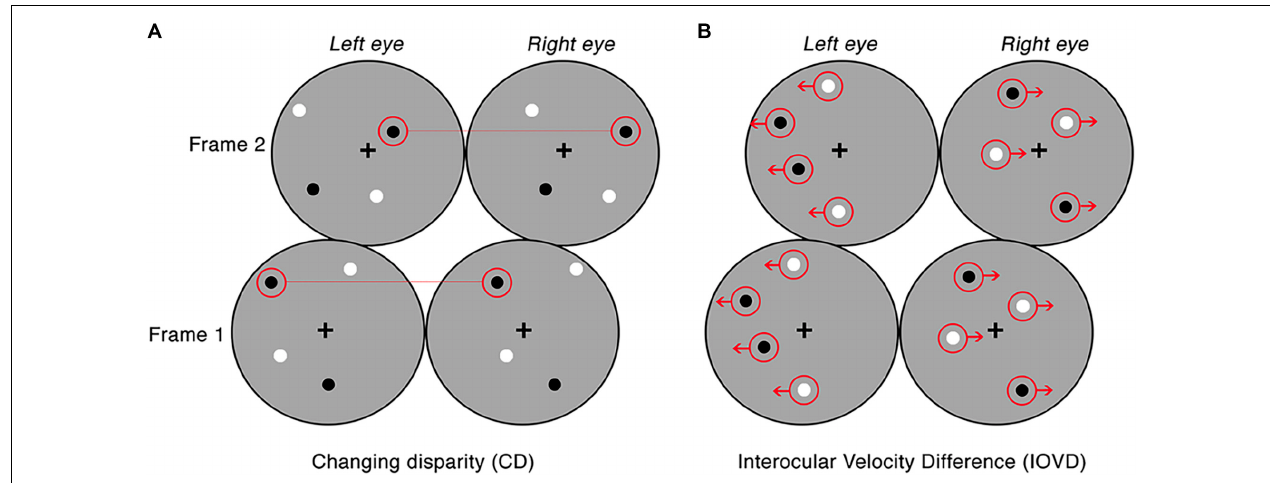
FIGURE 1 | Examples of the CD and IOVD stimuli presented across two consecutive frames. Panel (A) illustrates CD, where the dots are positioned randomly and paired between the left and right eyes and only differ in their lateral shift in disparity across each video frame. Panel (B) illustrates IOVD, where the dots laterally shift through time and there is no pairing of dots between the left and right